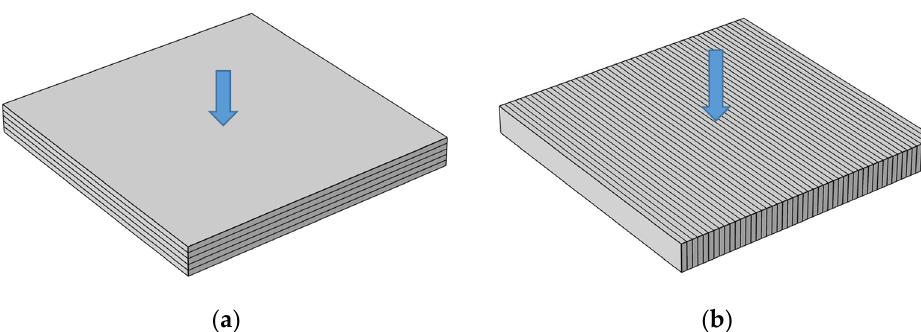
Figure 2. Specific heat test specimen.